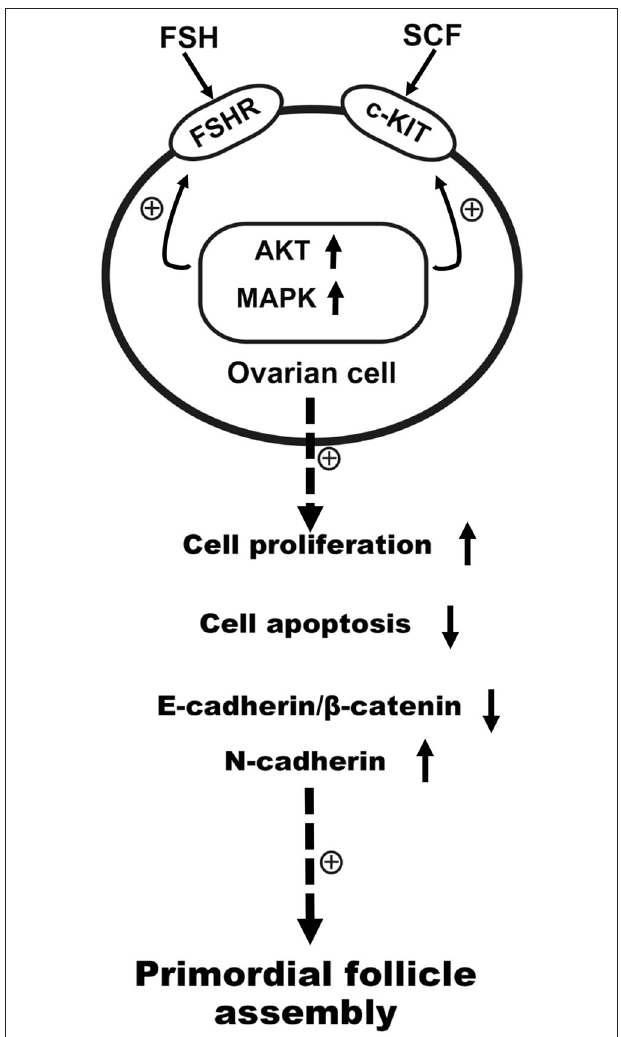
FIGURE 12 | Schematic illustration of FSH and KIT signaling in promoting primordial follicle assembly in the chicken. FSH promoted primordial follicle formation, and KIT signaling augmented the sensibility of FSHR to FSH via intracellular signal transduction. In the process of primordial follicle formation in the chickens, FSH cooperated with SCF reciprocally to promote cell proliferation, the expression of N-cadherin, and transcription factors, but also acted to inhibit E-cadherin/ β -catenin and cell